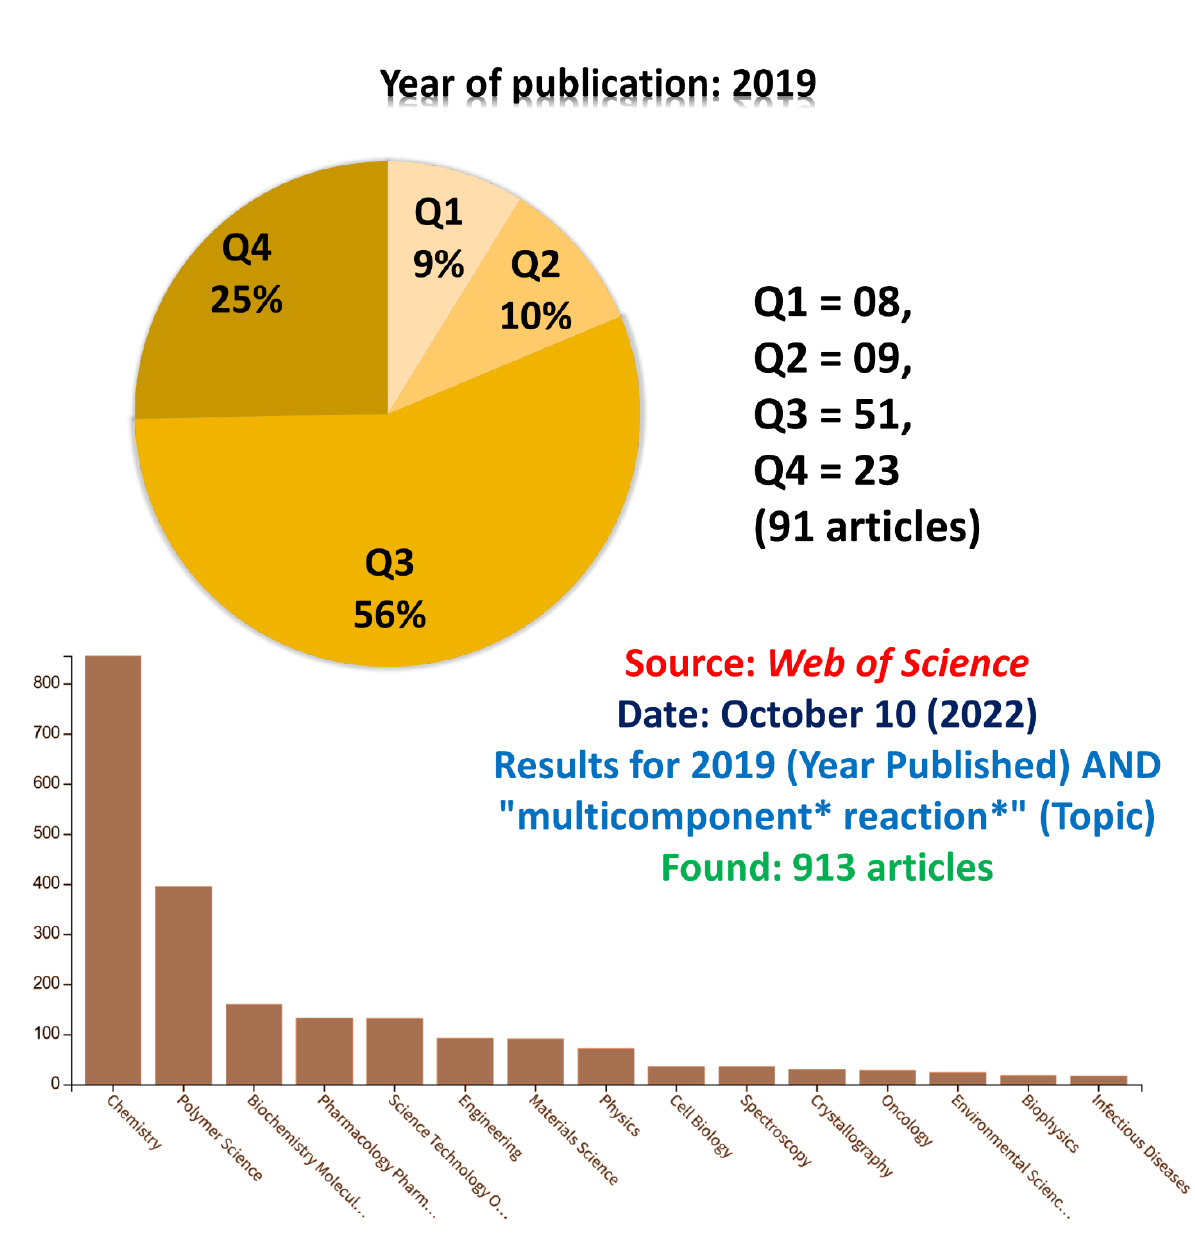
Figure 3. Results for 2019 (Year Published) AND “multicomponent * reaction *” (Topic). Found: 913 articles. Source: Web of Science .